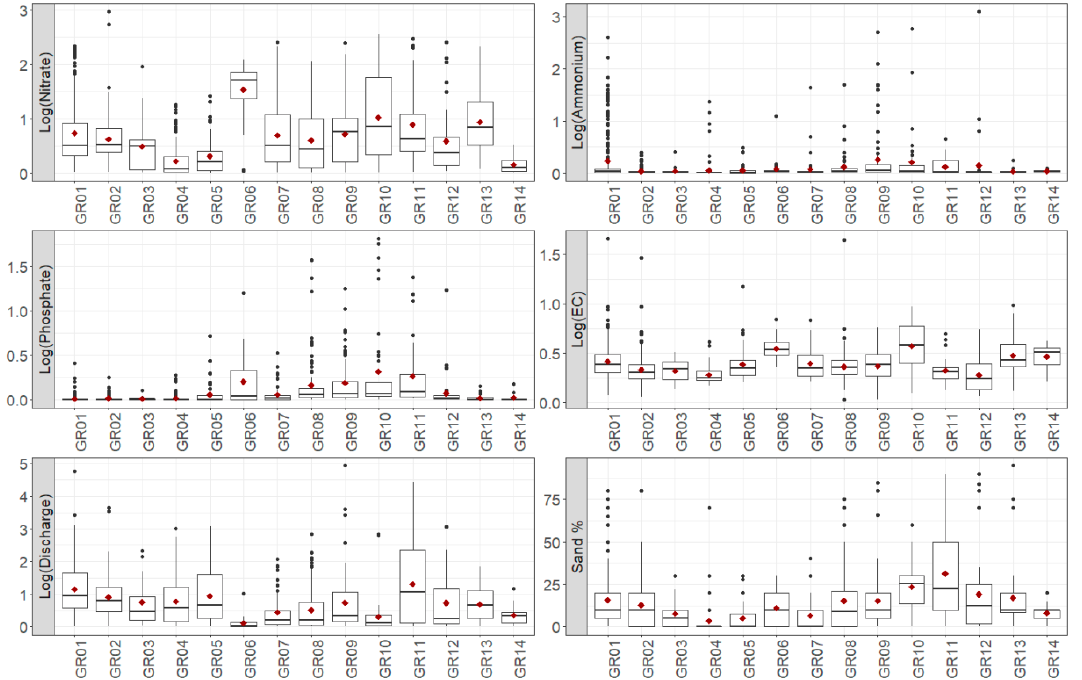
Figure 7. Boxplots for key variables per River Basin District (RBD). The red dot represents mean values.